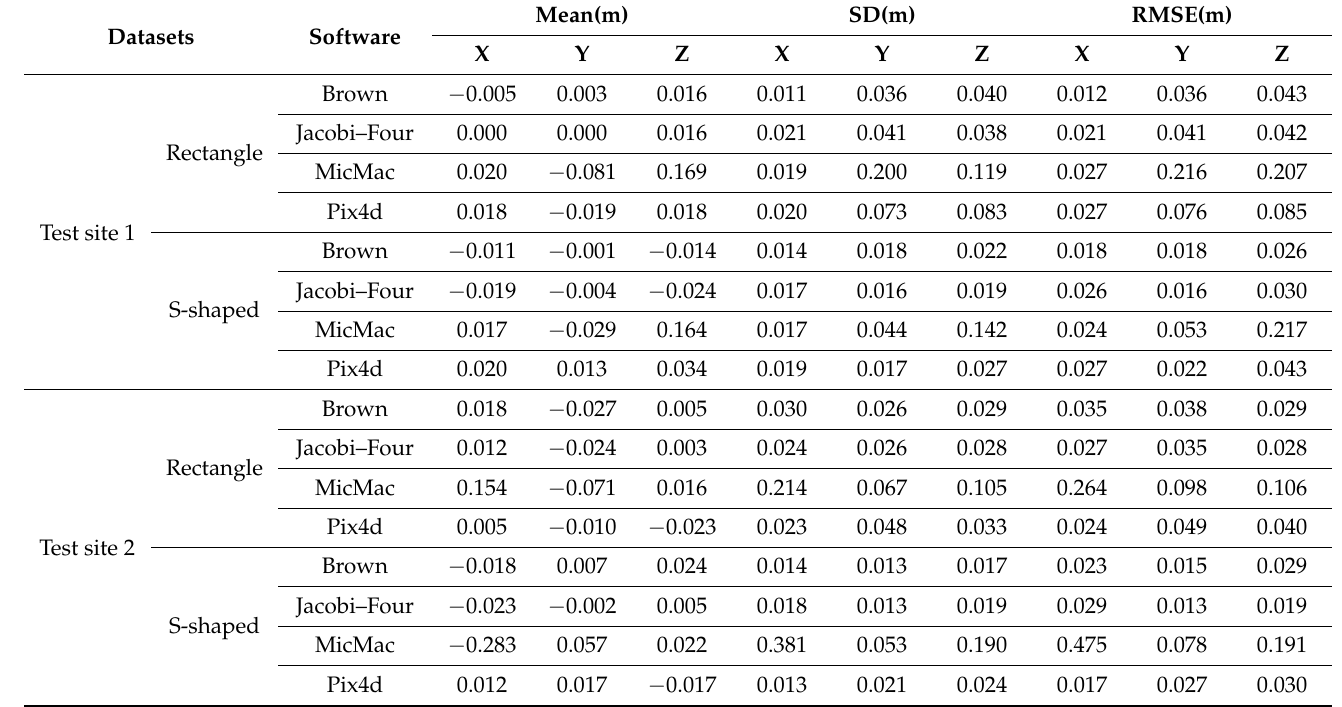
Table 6. Statistical results of self-calibration for different software with one single ground control point